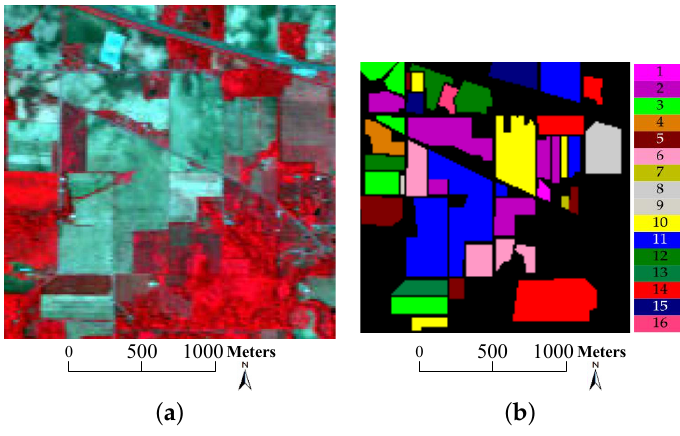
Figure 5. Indian Pines image: ( a ) Three-band false color composite; ( b ) Ground truth data with 16